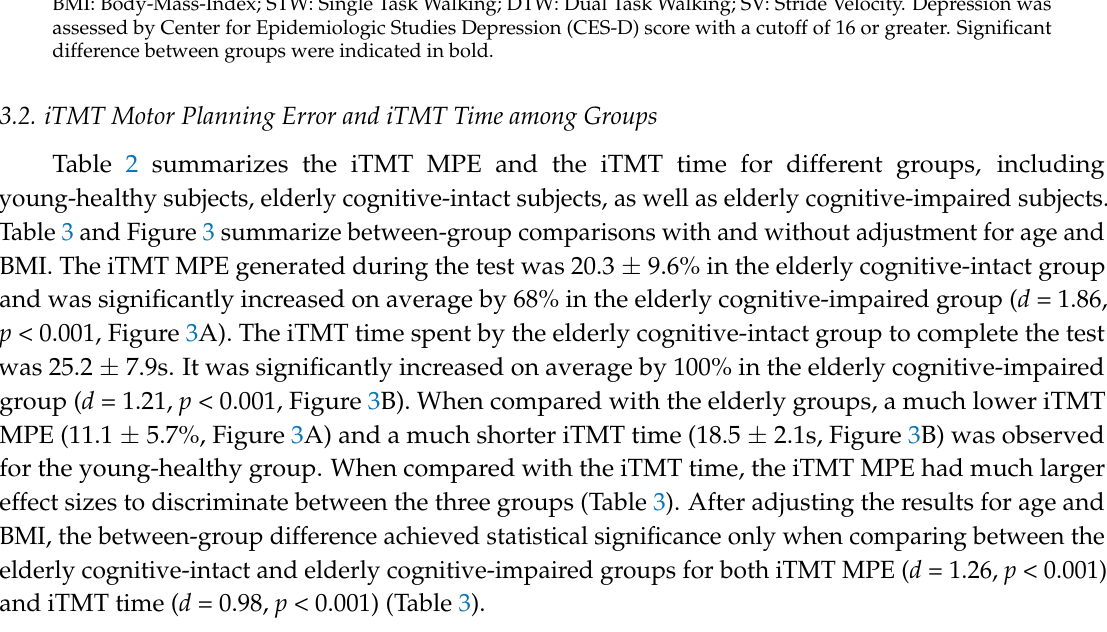
Table 2. iTMT derived parameters for different